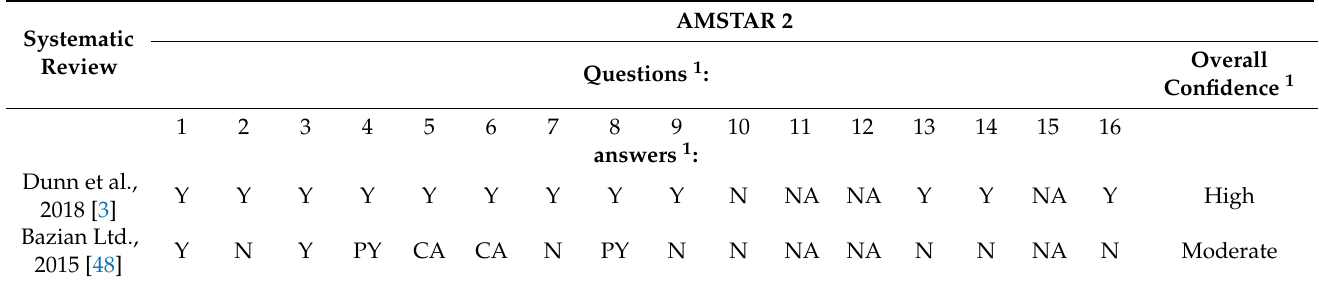
Table 4. AMSTAR 2 ratings of the methodological quality of the included systematic reviews, used for the formulation of recommendations in the analysed